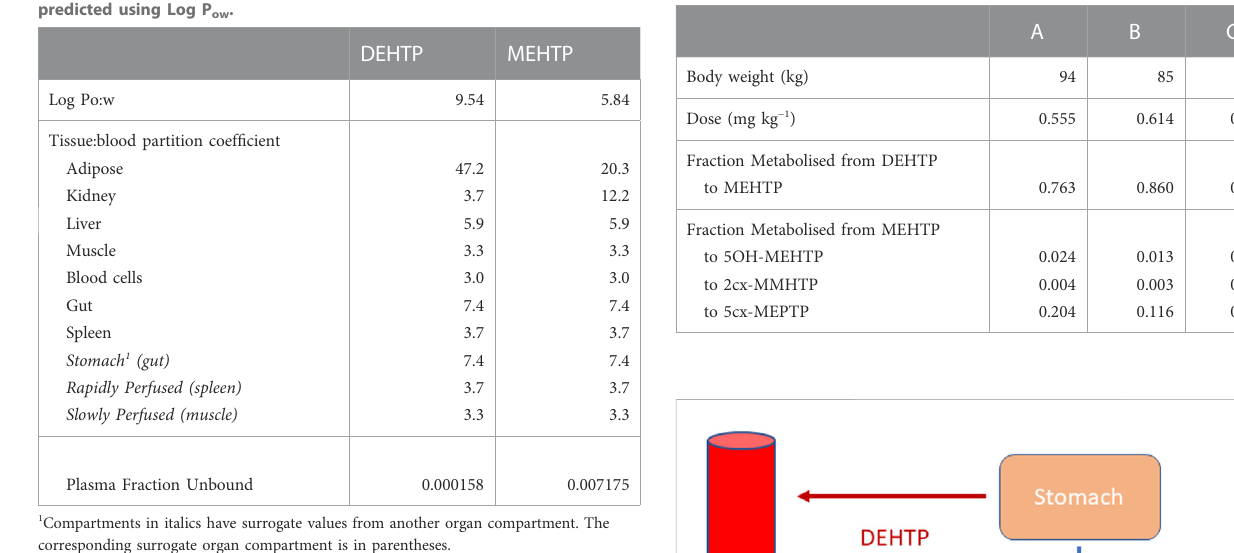
TABLE 2 Volunteer speci fi c parameters.